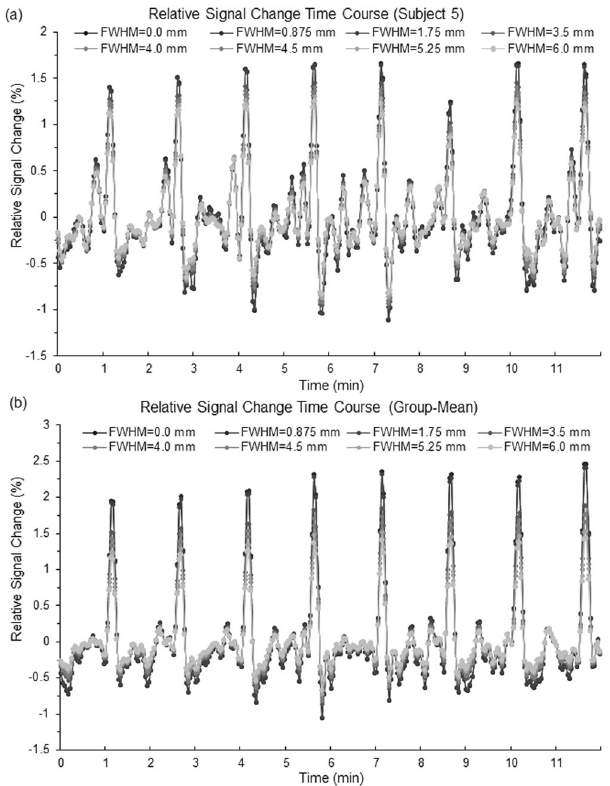
Figure 7. Illustration of the effect of spatial filtering on the signal time courses of the FT-associated FAUPAs identified in the left primary motor cortex. ( a ) The variation of the relative signal change time course with FWHM for subject 5; and ( b ) The variation of the group-mean relative signal change time course with